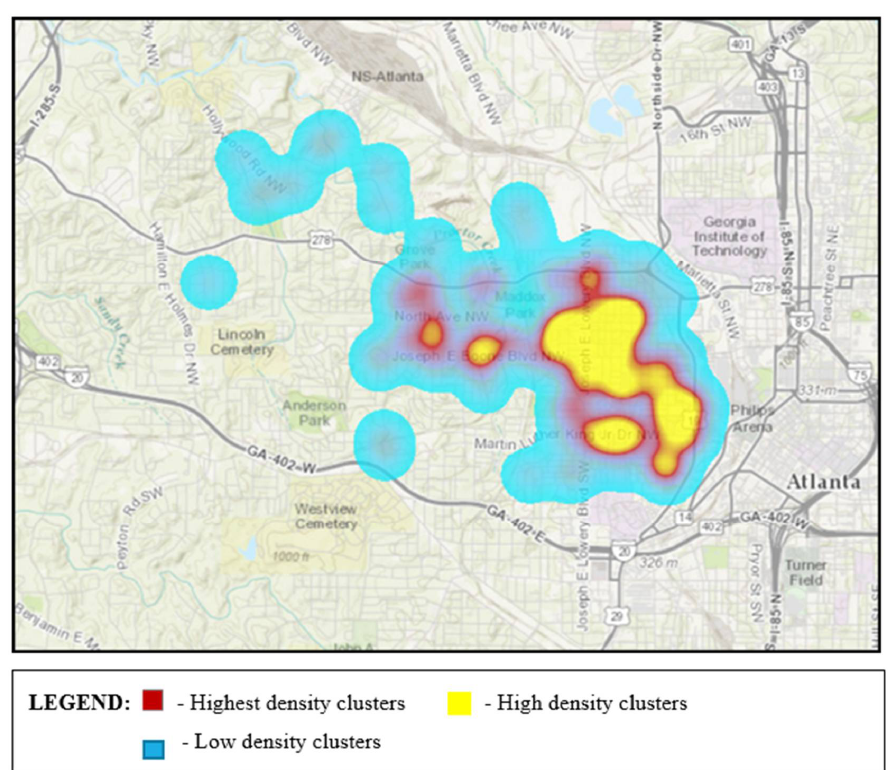
Figure 5. Areas of highest density (depicted by the colors yellow and red) of illegal dumping on land and locations of stormwater infrastructure problems in the Proctor Creek Watershed (does not denote statistical significance).